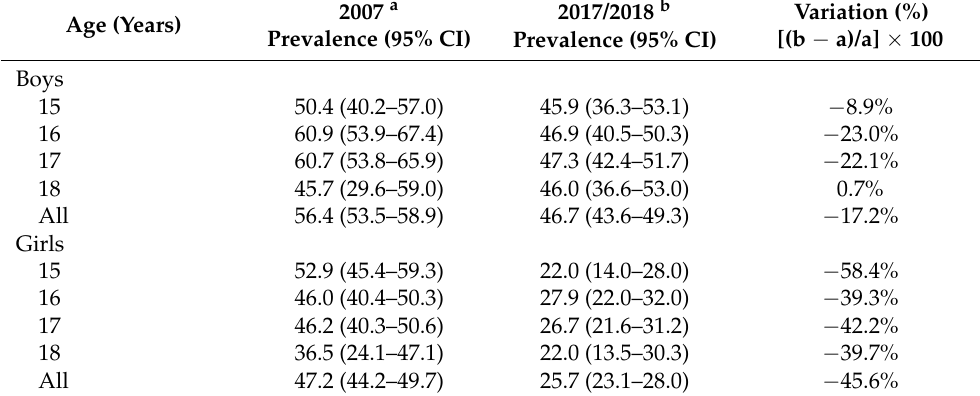
Table 2. Prevalence of sufficient physical activity in adolescents. Florianopolis, Santa Catarina,